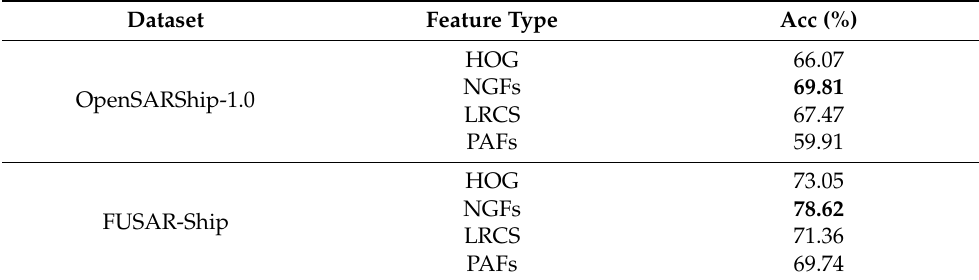
Table 6. SAR ship classification results on the OpenSARShip-1.0 and FUSAR-Ship datasets with pure traditional hand-crafted features based on